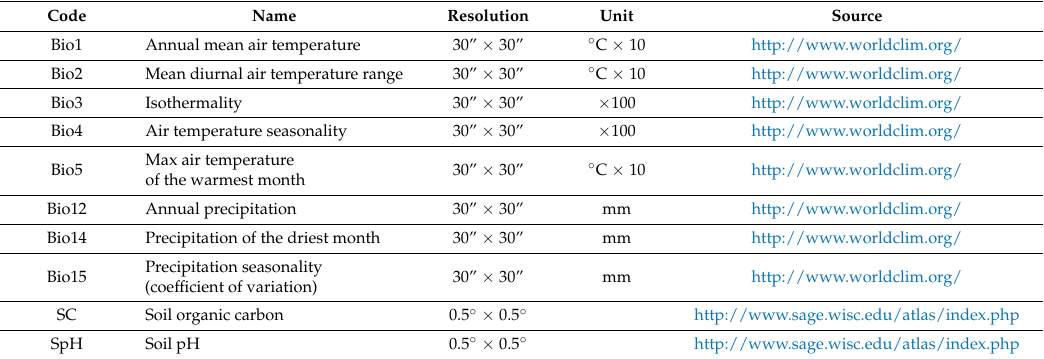
Table 1. Environmental parameters used to develop climate models for the five seed zones of Platycladus orientalis